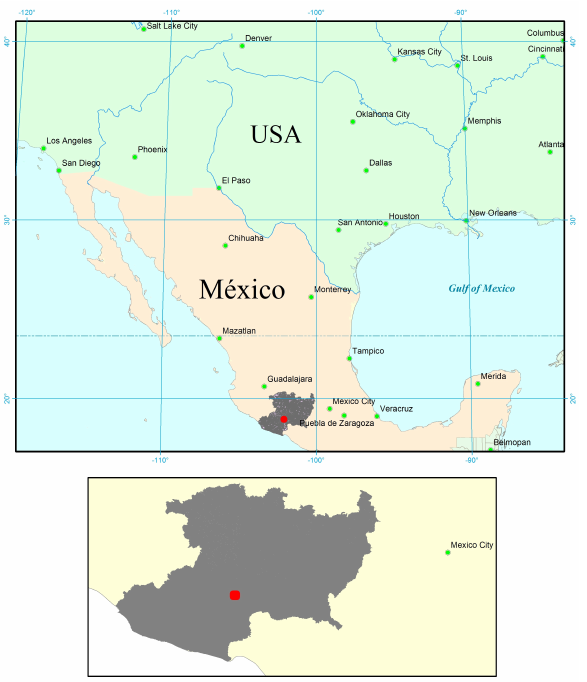
Figure 1: State of Michoac´an, Mexico. The red square is the area represented in the subsequent figures